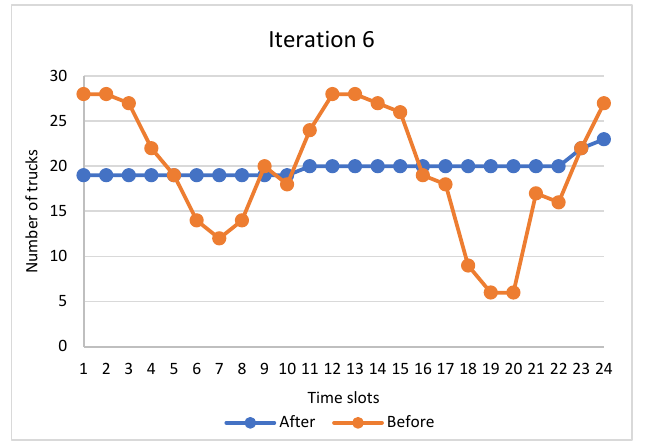
Figure 12. The workload before and after using balancing constraint on iteration 6.